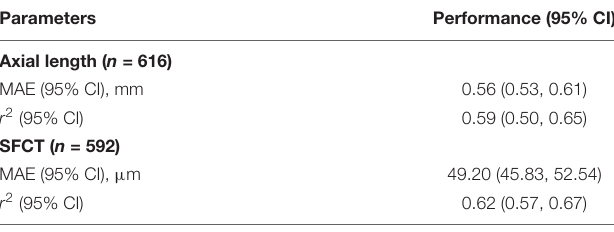
TABLE 2 | Algorithm performance in the validation set.